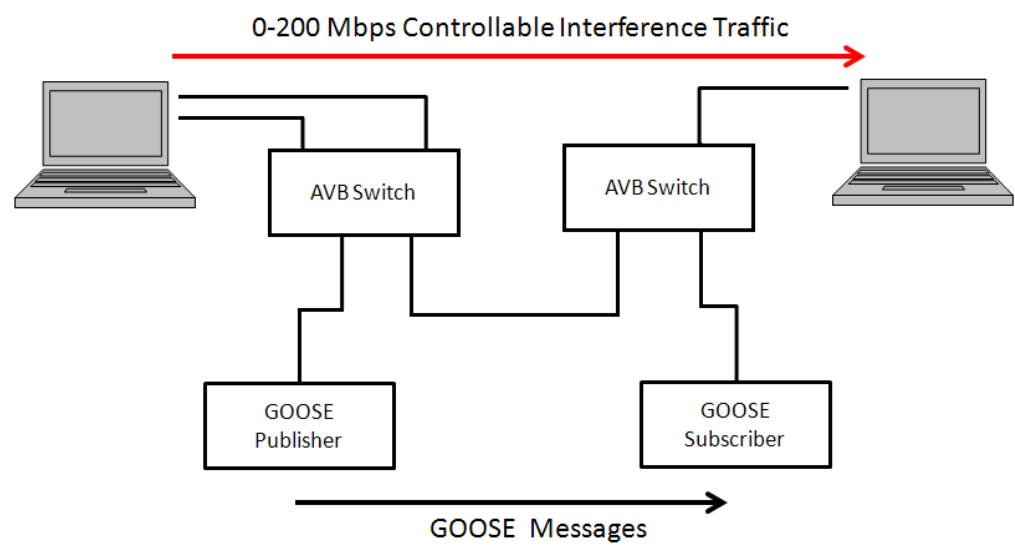
Figure 7. Schematic of experiment one configuration.